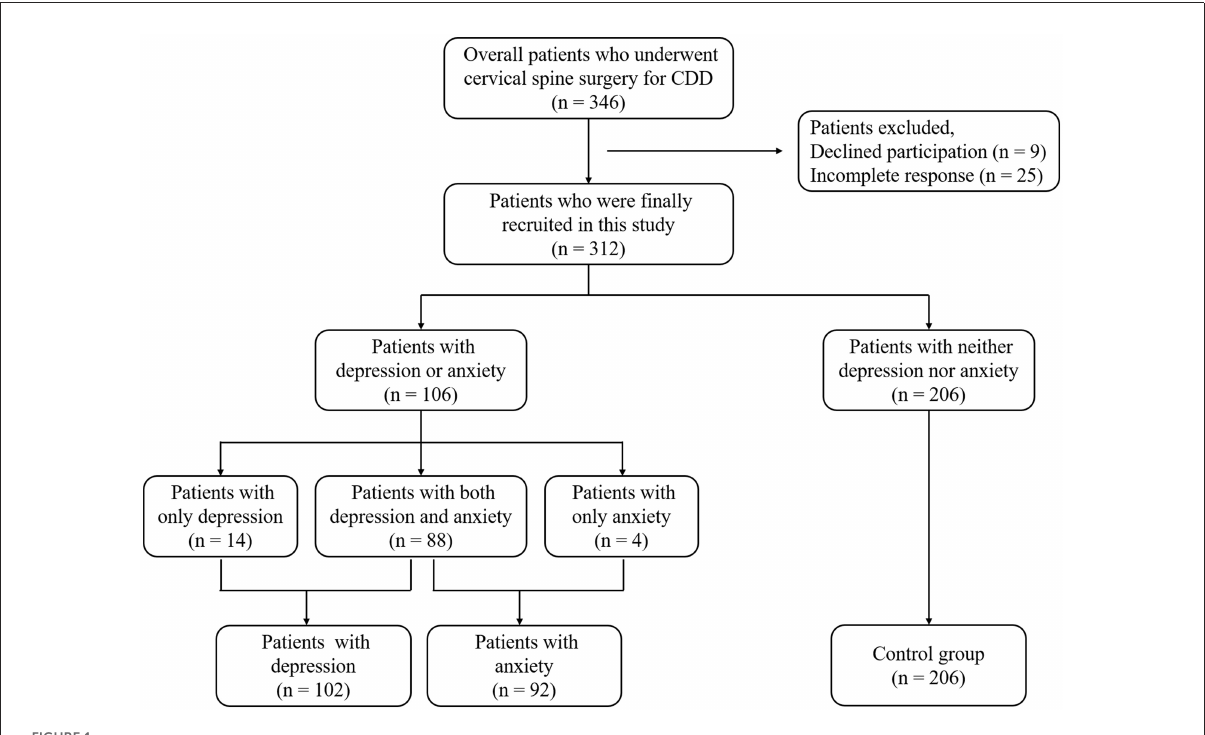
FIGURE1 Flowchart of the study